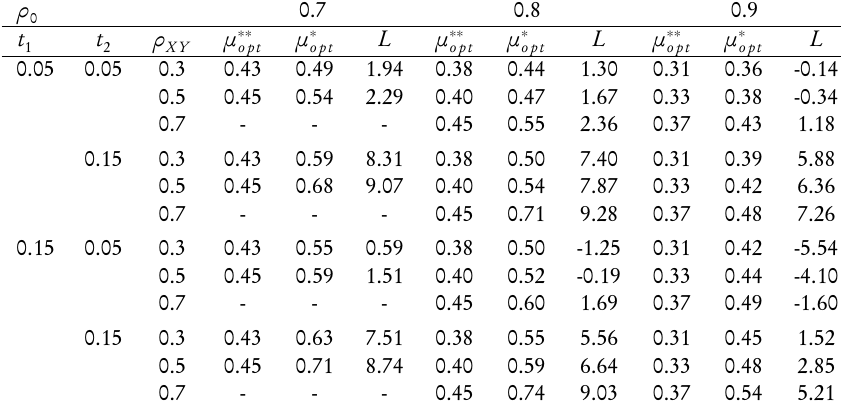
and µ ∗∗ for different values of ρ opt opt